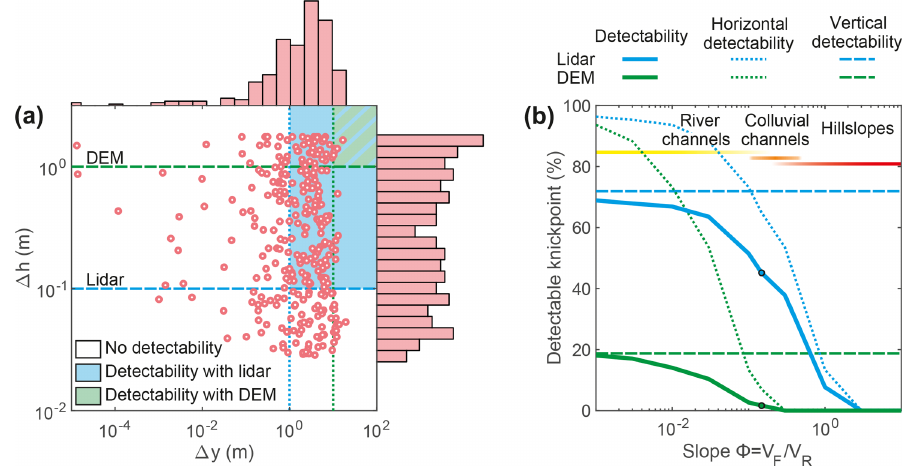
Figure 12. Spatial detectability of individual knickpoints. (a) Detectability for the “only seismic slip” model of knickpoints (pink circles) depending on their height (cid:49)h and horizontal distance (cid:49)y . Limits of resolution (dotted lines) and precision (dashed lines) are indicated for DEM (green) and lidar data (blue). Domains of DEM or lidar detectability are indicated by plain green or blue colours, respectively. The marginal distributions are indicated by pink bars. (b) Full (bold lines), horizontal (dashed lines) and vertical (dotted lines) knickpoint detectability when varying the ratio ϕ between knickpoint retreat rate V R and fault slip rate V F . ϕ also represents the river slope, and the domains of river channels, colluvial channels and hillslopes are indicated by yellow, orange and red bars. Knickpoint detectability is given as a percentage of the number of detected knickpoints over the total number of knickpoints. The blue and green dots represent detectability for the model presented in panel (a)